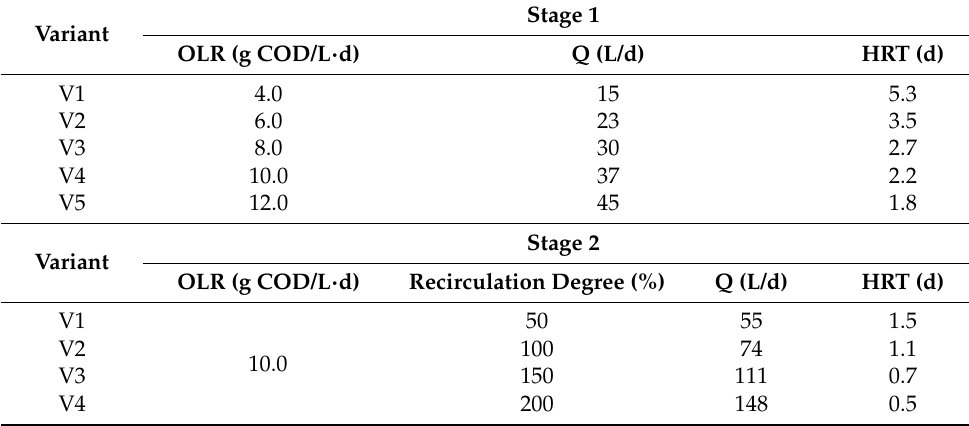
Table 3. The study organization and exploitation parameters in stages 1 and 2.